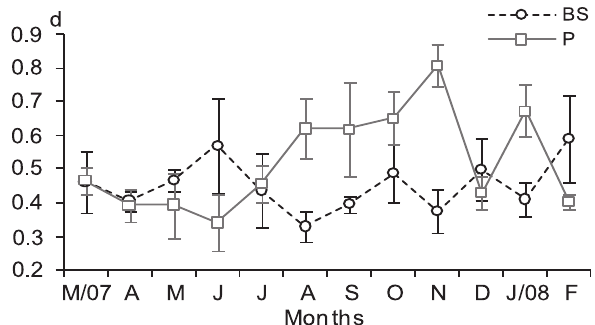
Figure 9. Monthly mean variation (± standard error) of the domi- nance index (Berger-Parker d) of ichthyofauna collected as accom- panying fauna in artisanal seabob shrimp fisheries in Balneário Barra do Sul (BS) and Penha (P) between March 2007 and February 2008.